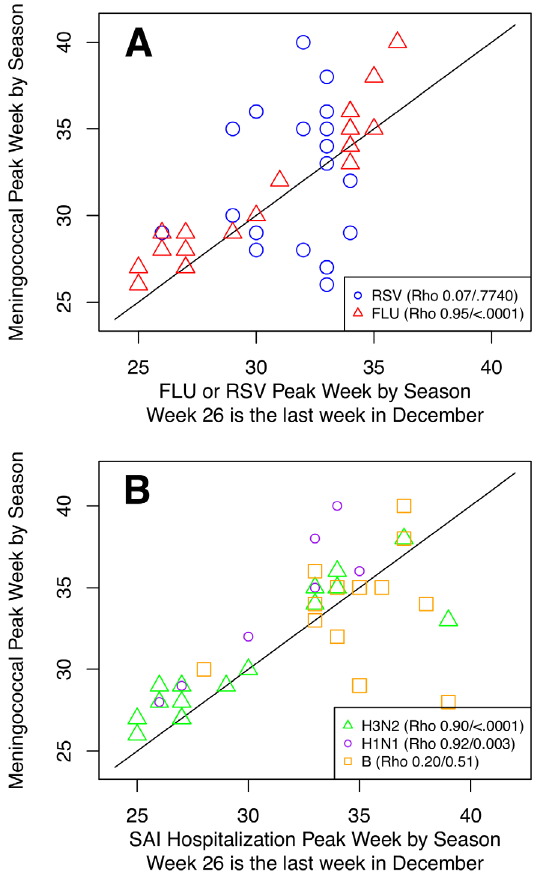
Figure 1. Meningococcal disease (MD) annual peak timing shows strong correlation with peak of influenza (FLU), especially A/H3N2 and A/H1N1 but not RSV. A We analyzed 20 seasons and defined the week for each season in which FLU, RSV, or MD had the maximum count as the peak week. The synchrony of the peak week for FLU, RSV, and MD was compared. FLU (marked by a blue triangle) peaked 2 weeks or less before MD in all seasons but one. The peak weeks were highly correlated ( r =0.95; P , .001). In contrast, RSV (marked by circles) was not synchronized with MD ( r =0.07; P =.77) and peaked equally before and after MD. B Same analysis repeated for each season and each influenza subtype. Including only seasons with at least 75 subtype-attributable influenza hospitalizations, we analyzed 16 (H3N2), 7 (H1N1), and 13 (B) seasons for correlation with MD. H3N2 ( r = 0.90; P , .001) and H1N1 ( r = 0.92; P =.003) were highly synchronized with MD hospitalizations while influenza B showed little evidence of an association ( r =0.20; P =.51). During our study period, influenza B was the dominant strain in only 2 seasons but in those years peaked with (1990 2 91) or 1 week before MD (1992 2 93). The only season when H3N2 or H1N1 peaked after MD was 1992 2 93 when B